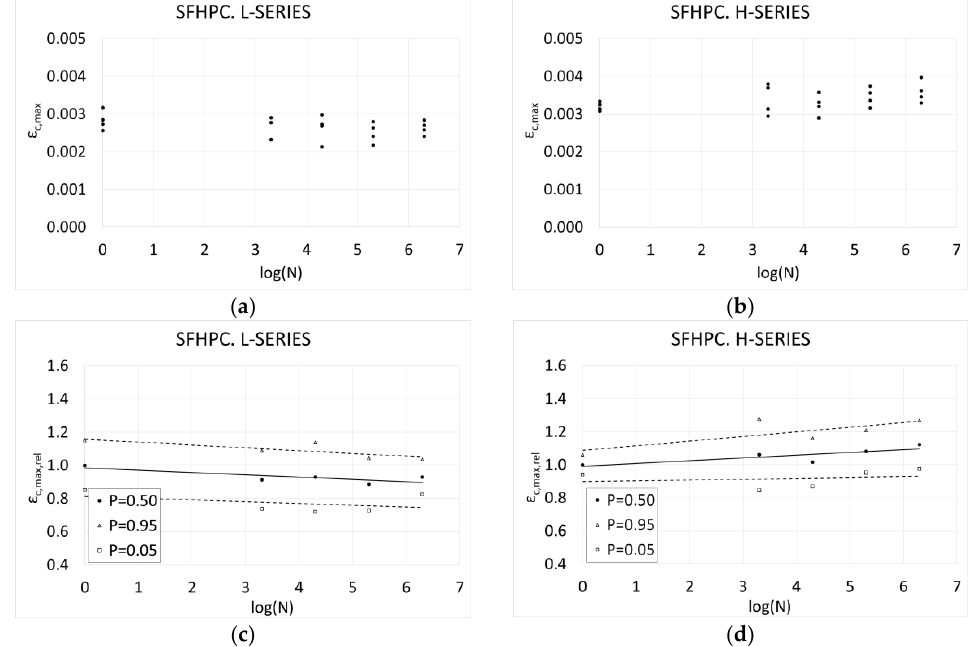
Figure 11. Range of maximum compressive strain by number of cycles. SFHPC ( a ) L-Series. Raw values. ( b ) H-Series. Raw values. ( c ) L-Series. Maximum, minimum, and average relative values, and tendency lines. ( d ) H-Series. Maximum, minimum, and average relative values, and tendency lines.